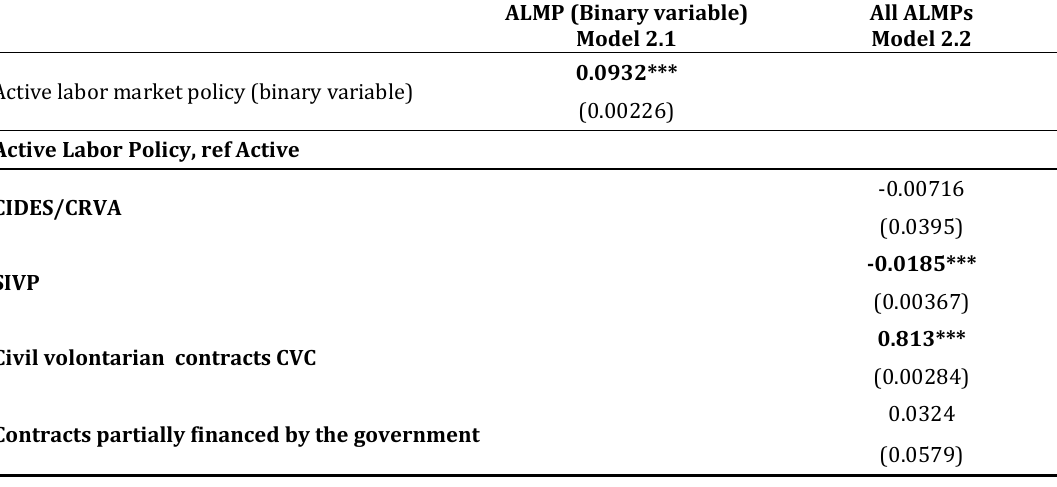
Table 2 : ALMPs effects on professional insertion